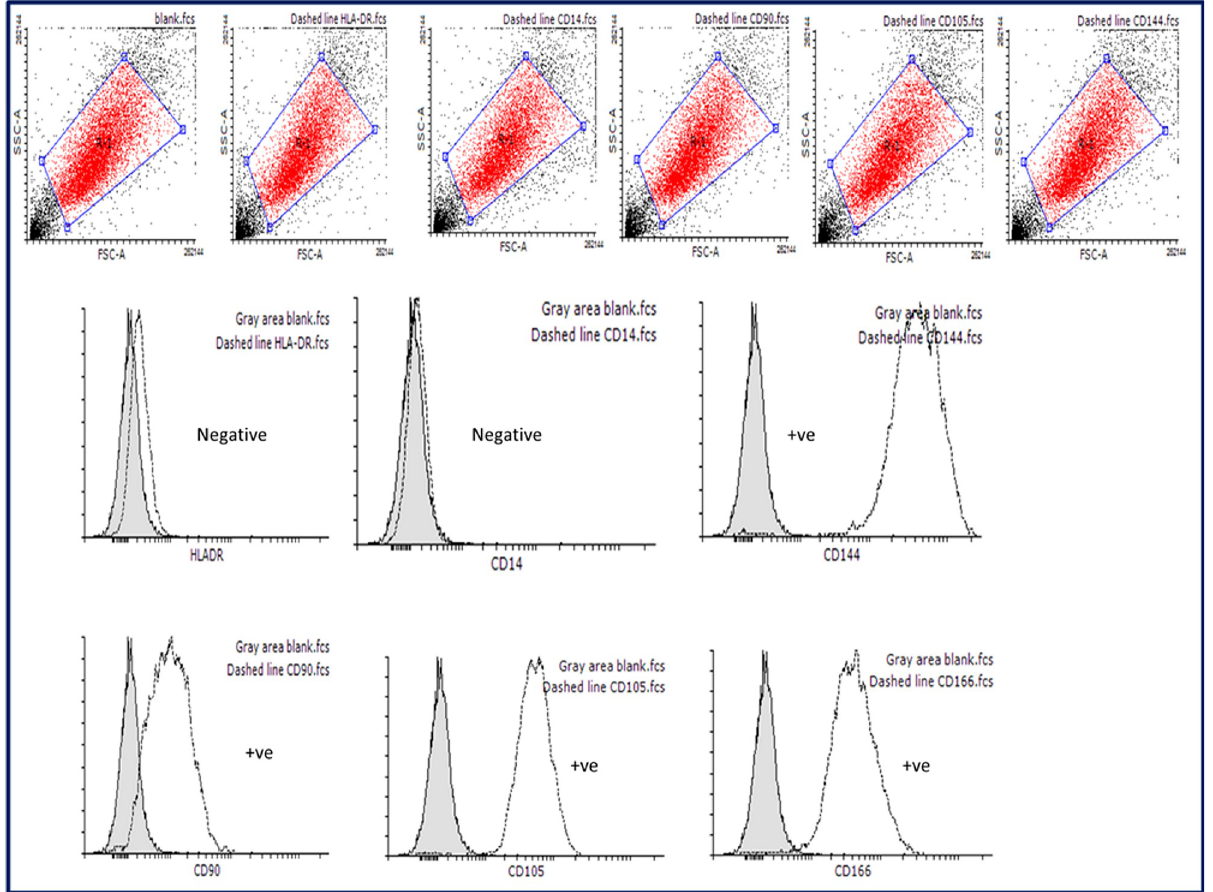
Fig 1. Validation of MSCs markers by flow cytometry. MSCs found positive for the following markers CD144, CD90, CD105, and CD166. In addition, MSCs were negative for HLA-DR, and CD-14 markers. These results are typical for MSCs validation assay.